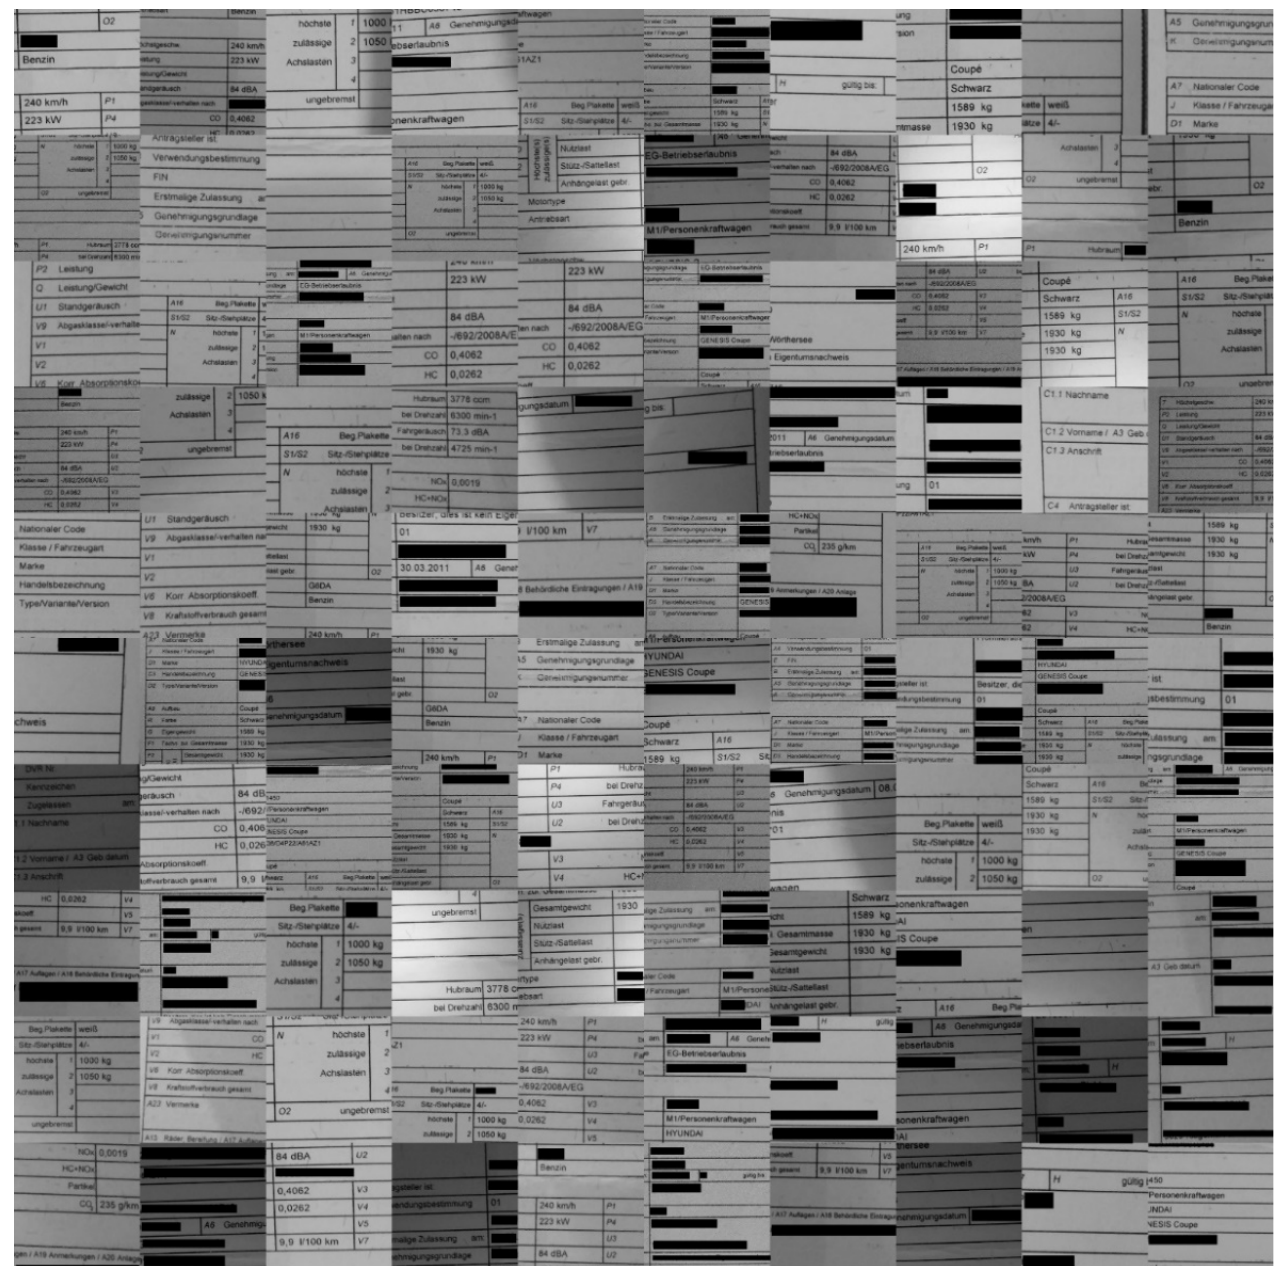
Figure 8. These are 100 “middle quality” sample data extracted from our own dataset (an extract from a much bigger dataset). Note: since the images contain some personal data, those parts are covered by black rectangles for privacy reasons.